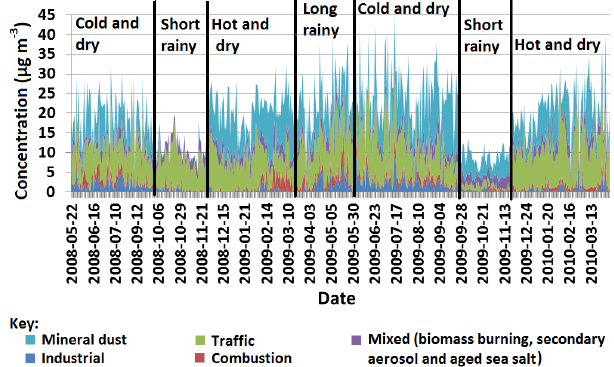
Figure 11. Industrial factor from analysis of sampled PM 2 . 5 show- ing the contribution of metallurgy industries (Fe and Zn) to aerosol in Nairobi.